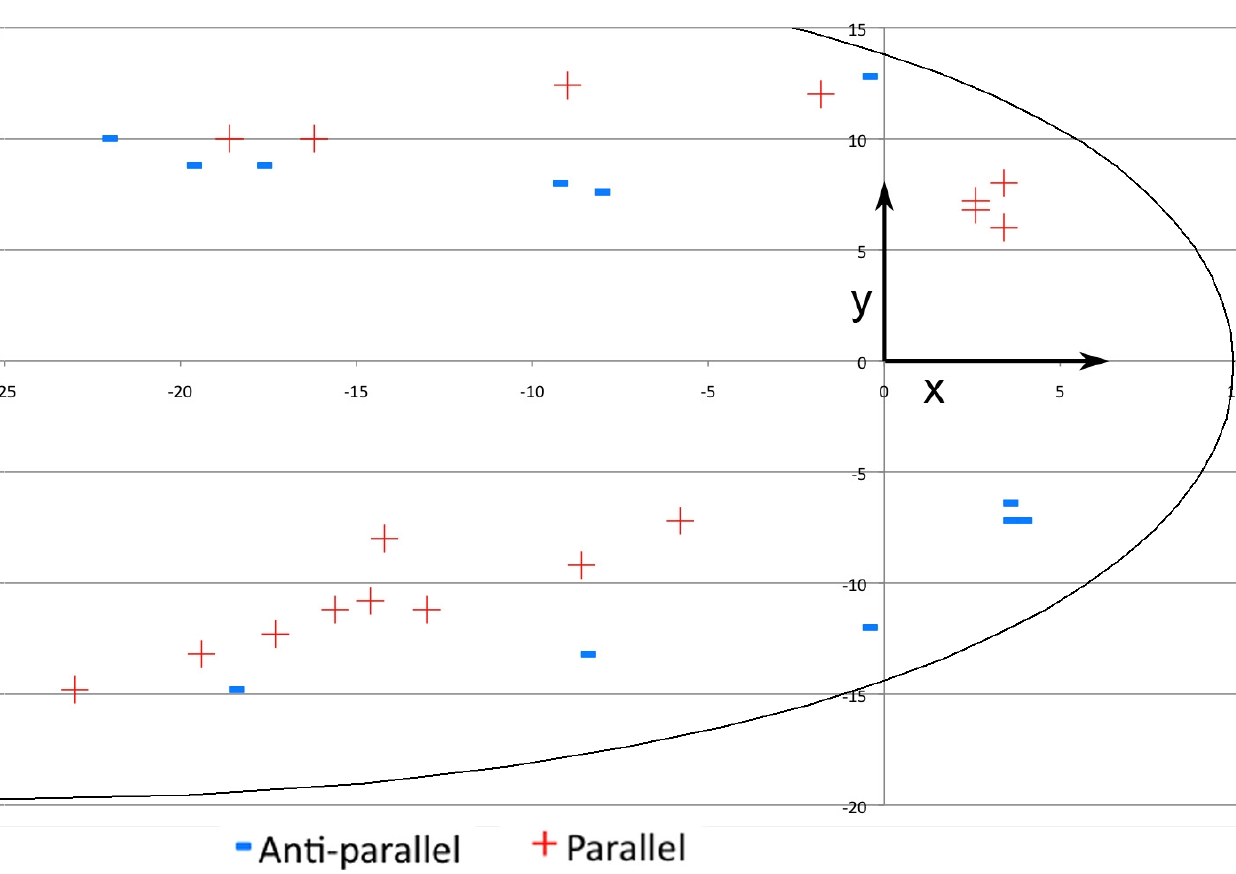
vortices that formed almost with the same x - y coordinates, but with totally different z